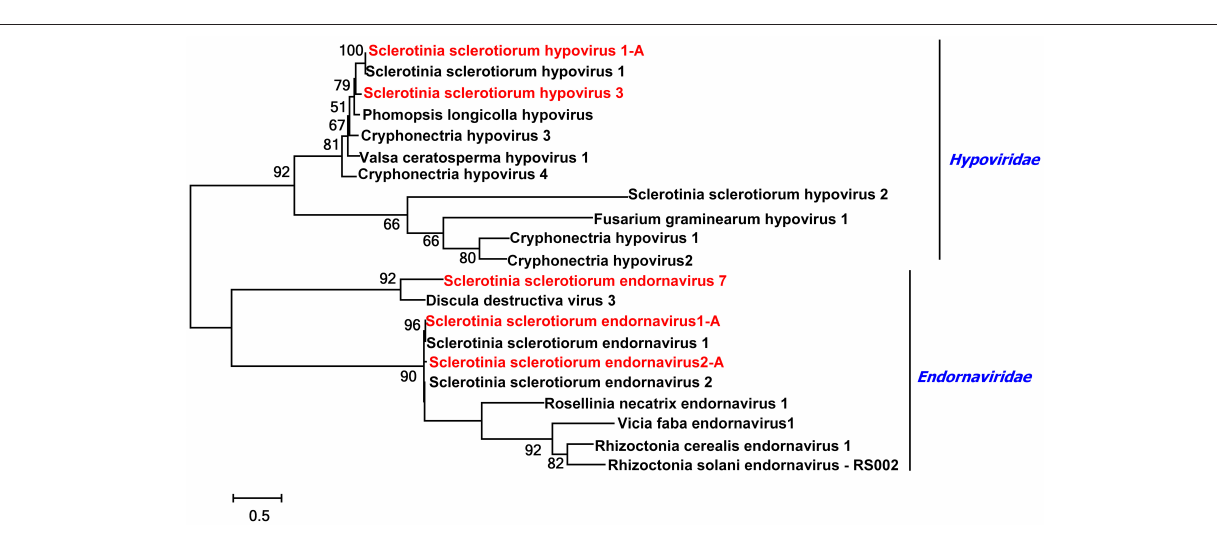
FIGURE 5 | Phylogenetic analysis of viruses in the Family Endornaviridae and Hypoviridae. Phylogenetic analysis of viruses in the Family Endornaviridae and viruses in the Family Hypoviridae based on multiple alignments of full-length RdRp amino acid sequences. Viruses marked with red color are found in Australian isolates of Scleorotinia sclerotiorum